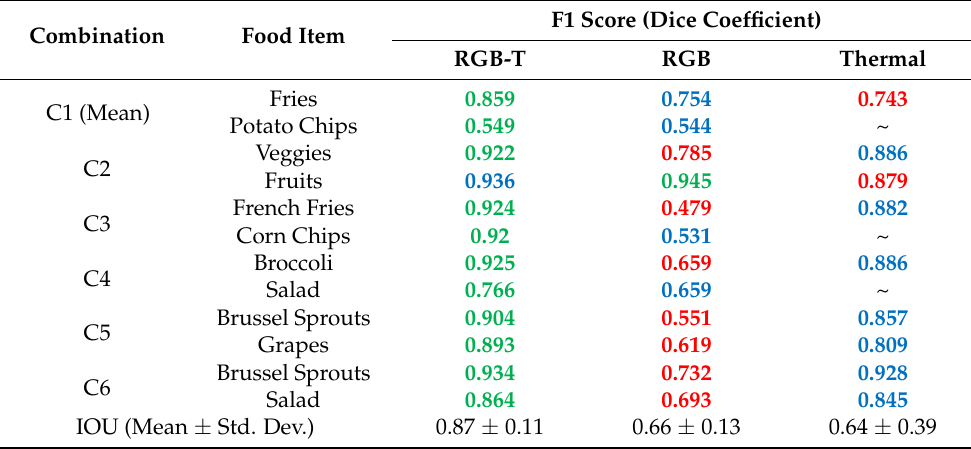
Color code (Ranked for each row): Green = Highest, Blue = 2nd Highest, Red = Lowest, ~ = No meaningful